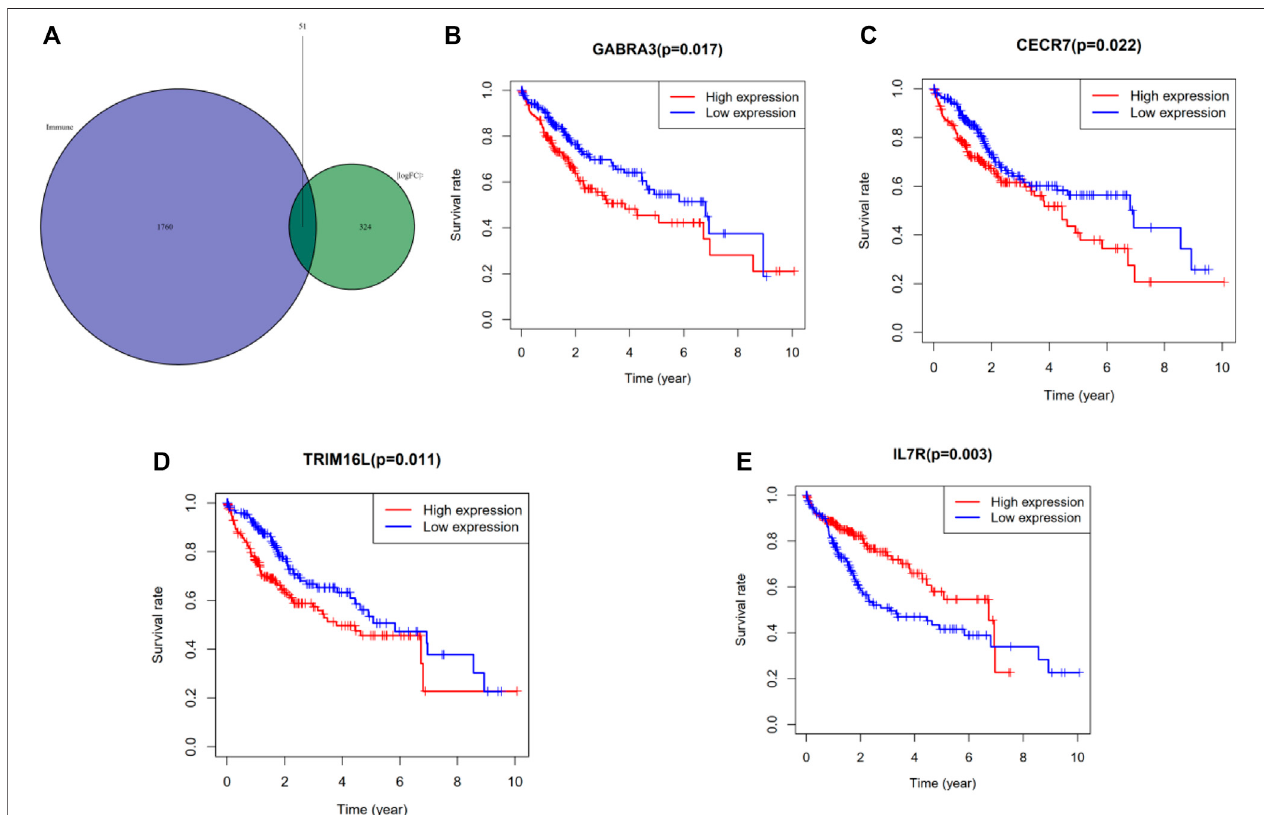
FIGURE 5 | Identi fi cation of signi fi cant immune genes for HCC prognostication. (A) The Venn diagram showed that a total of 51 differential immune genes were associatedwithtumor mutationburden andimmune in fi ltration.Kaplan – Meieranalysisrevealedthatdown-expressionofGABRA3,CECR7, TRIM16andup-expression ofIL7Rwereassociatedwithbettersurvivaloutcomesandlowrecurrence. (B) GABRA3( p (cid:1) 0.0017) (C) CECR7( p (cid:1) 0.022) (D) TRIM16L( p (cid:1) 0.011) (E) IL7R( p (cid:1) 0.003)